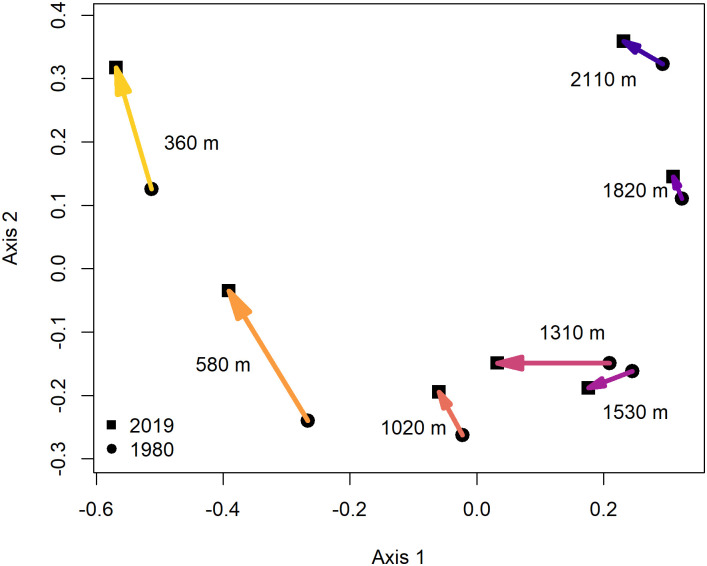
Shifts in the community composition of understory birds across an elevation gradient between 1980 and 2019 in the Usambara Mountains, Tanzania.Species composition is based on a Principal Coordinate Analysis of a Bray-Curtis dissimilarity matrix. Closer points are more similar in community composition. Arrows point from the historic to the current community composition at each site.